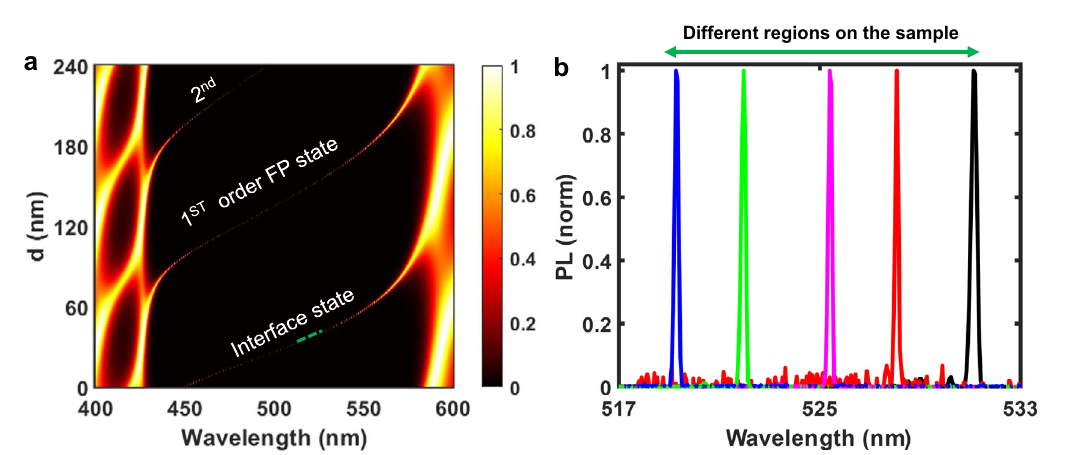
Fig. 5 | Tunable topological interface-state cavity lasers. a Calculated transmis- sion spectra of the 1D topological cavity as function of the thickness of the fi rst HI layer next to the interface ( d ). b Tunable single-mode laser emission wavelength